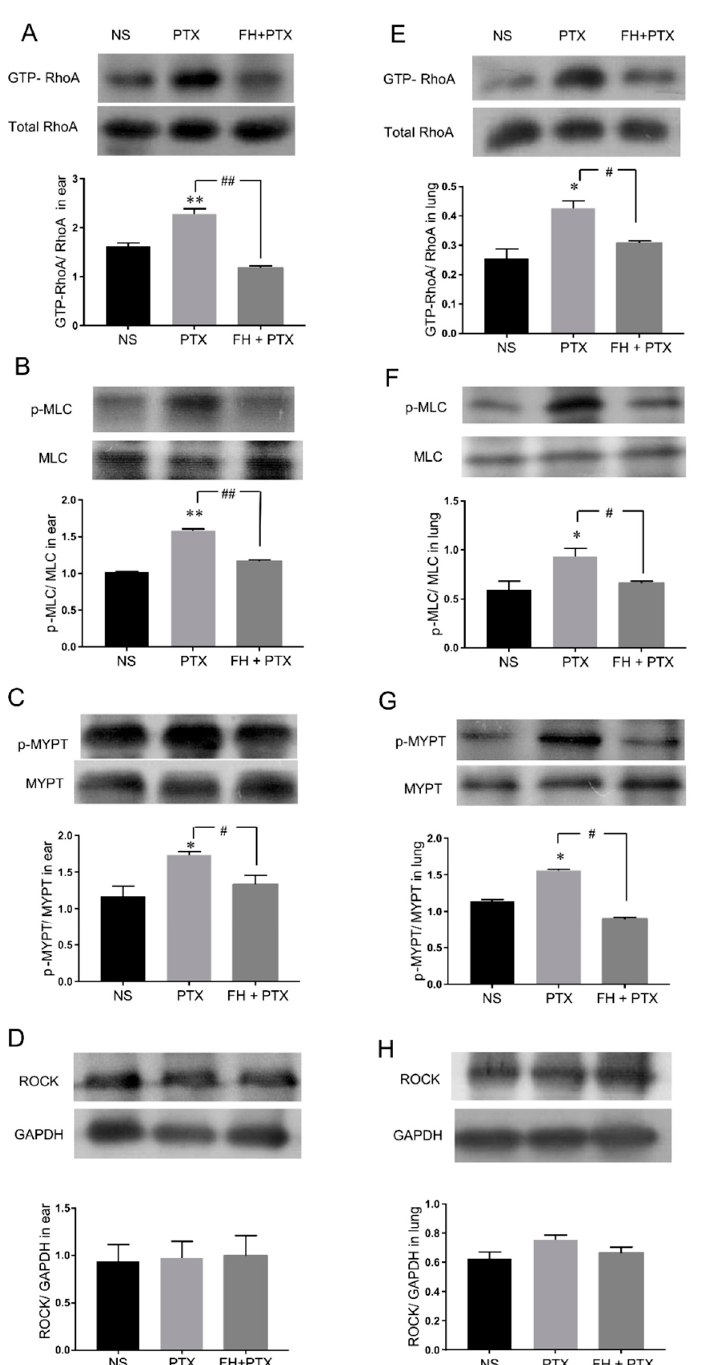
Figure 4. The inhibitory effect of fasudil hydrochloride (FH) on upregulation of key proteins in RhoA/ROCK pathway induced by PTX injection in mice ear ( A , B , C , D ) and lung ( E , F , G , H ) ( n = 3 per group). ( A , E ) GTP-RhoA/total RhoA in mice ear or lung with PTX injection (16 mg/kg, iv) in the presence or absence of FH (30 mg/kg, ip). ( B , F ) p-MLC/MLC expression. ( C , G ) p-MYTP/MYPT value. ( D , H ) ROCK/GAPDH. *p < 0.05, and **p < 0.01, compared with the NS-treated group, #p < 0.05 and ##p < 0.01 represented a significant difference between with and without FH